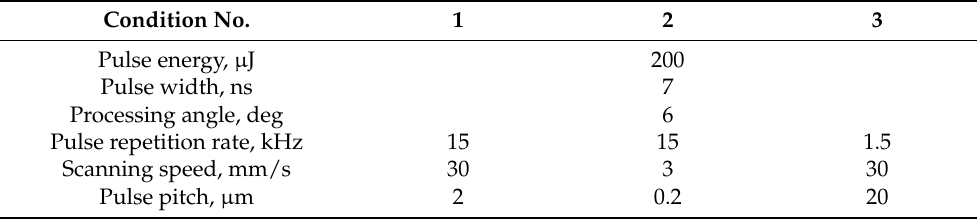
Figure 1. ( a ) Schematic of PLG processing of tool edge; ( b ) processing angle θ and processed angle ϕ before and after PLG; ( c ) ideal surface roughness after PLG processing. In this study, a nanosecond laser with a wavelength of 355 nm, generated by the third harmonic of a Nd: YAG laser, was employed. The laser beam was focused using a lens with a focal length of 10 mm and a spot diameter of approximately 25 µ m. The detailed PLG conditions are presented in Table 1. The pulse pitch was calculated by dividing scanning speed by repetition rate, and set as 2, 0.2, and 20 µ m. Table 1. PLG processing